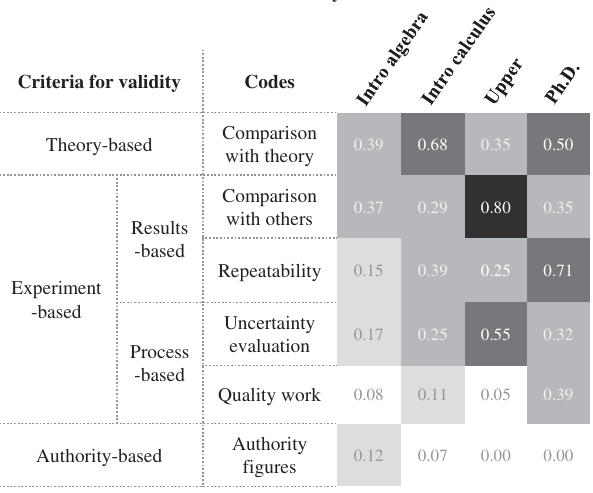
FIG. 2. Fraction of student responses with a particular code in the subpopulation (e.g., intro algebra-based physics). Students ’ responses may be coded under several codes when appropriate so fractions do not add up to 1.00. Five levels of gray scale shading were applied based on the fraction, f (from lightest to darkest): f < 10% (white); 10% ≤ f < 25% ; 25% ≤ f < 50% ; 50% ≤ f < 75% ; f ≥ 75%